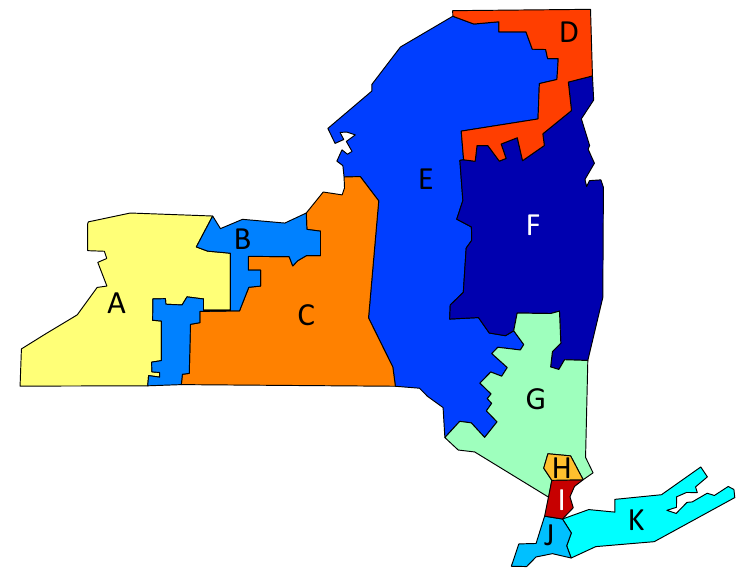
Figure 2. NYISO electrical regions map.